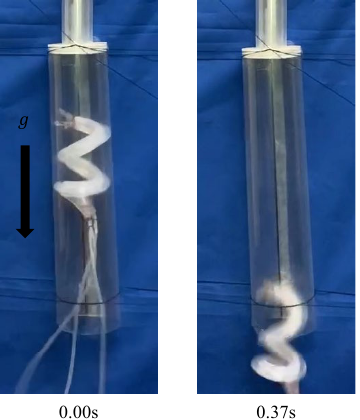
Figure 20. Experiment using a device with a uniform initial pitch of 320 mm driven into a vertically fixed pipe with the same diameter as that of the 50A and 20A pipes, where ( a , b ) show devices driven by air pressures of 0.17 MPa and 0.18 MPa, respectively.